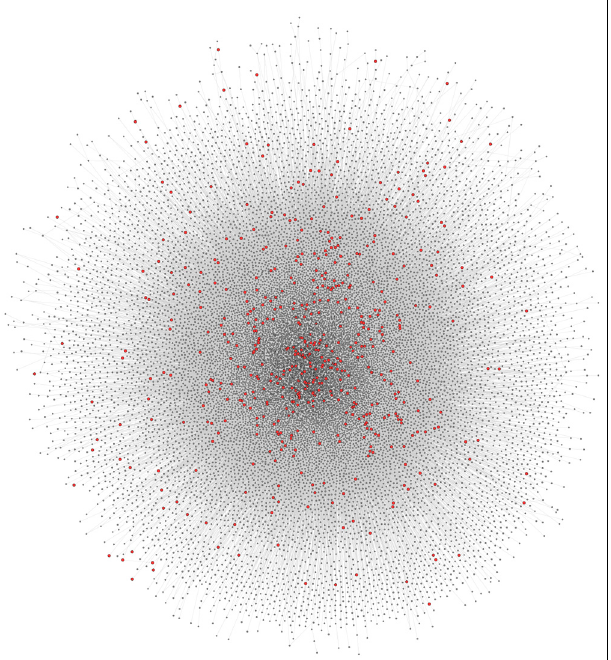
FIGURE 3 | Full CPDB protein interaction network. The network displays the full set of interactions available from CPDB used in this study. Circles (nodes) represent proteins, whereas the lines (edges) connecting two circles signify an interaction between two proteins. Locus heterogeneity genes relating to our 100 selected disorders are highlighted red, with gray nodes symbolizing other genes in the